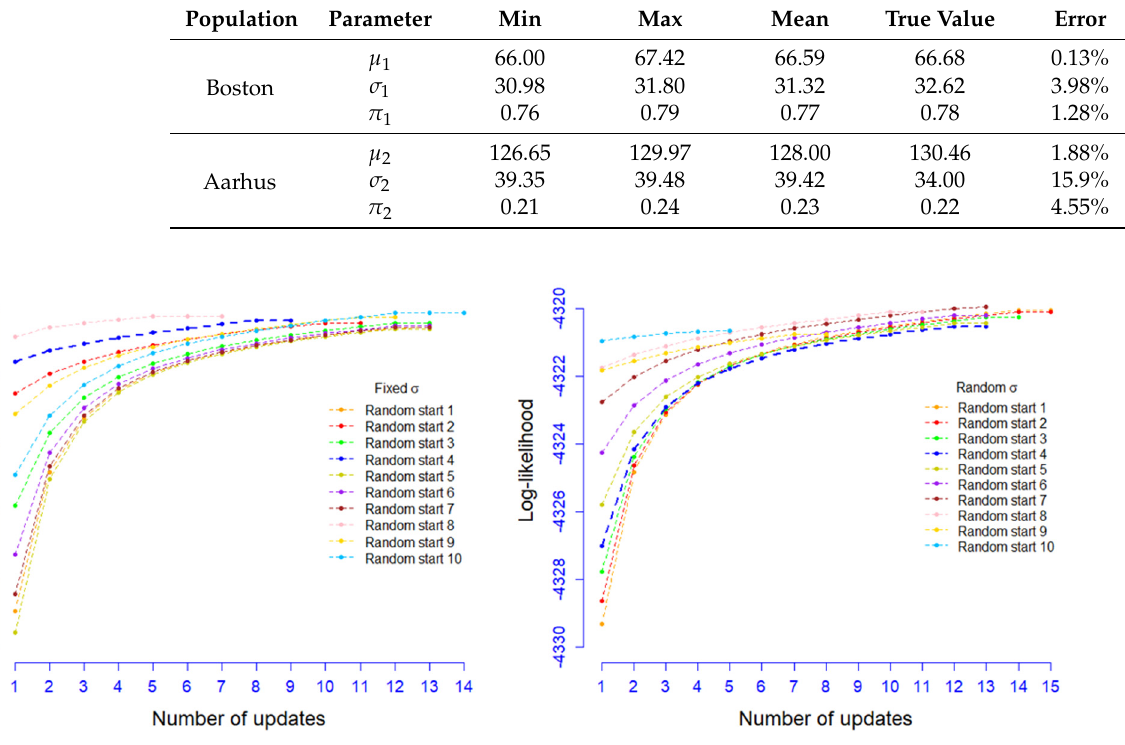
Figure 4. Log-likelihood performance for the univariate case.